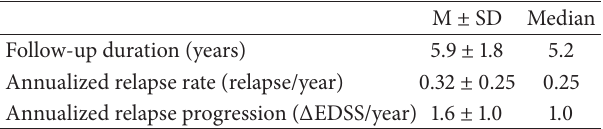
Table 3: Follow-up cohort